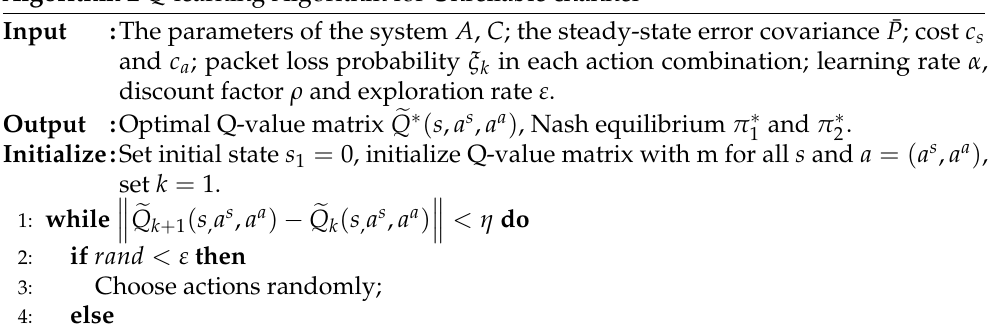
Algorithm 2 Q-learning Algorithm for Unreliable